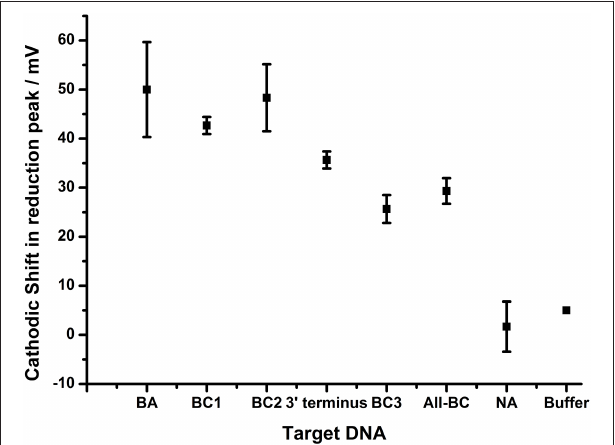
FIGURE 8 | The effect of DNA hybridization to probe BA-2. In each case the 3 ′ terminal nucleotide carrying the AQ tag is not homologous to any of the target DNA strands. In addition to the terminal mismatch, additional internal mutations were present within target DNA BC1, BC3 (1bp), BC2 (2bp), All-BC (3bp), and BWK (7bp). All measurements were made by DPV (scan − 0.4V to − 0.75V; 50mV s − 1 ) vs. SCE in 10mM Tris buffer pH 8 containing 0.5M NaCl. Points represent an average of the responses shown by three replicate electrodes (error bars are 95% confidence limits from this